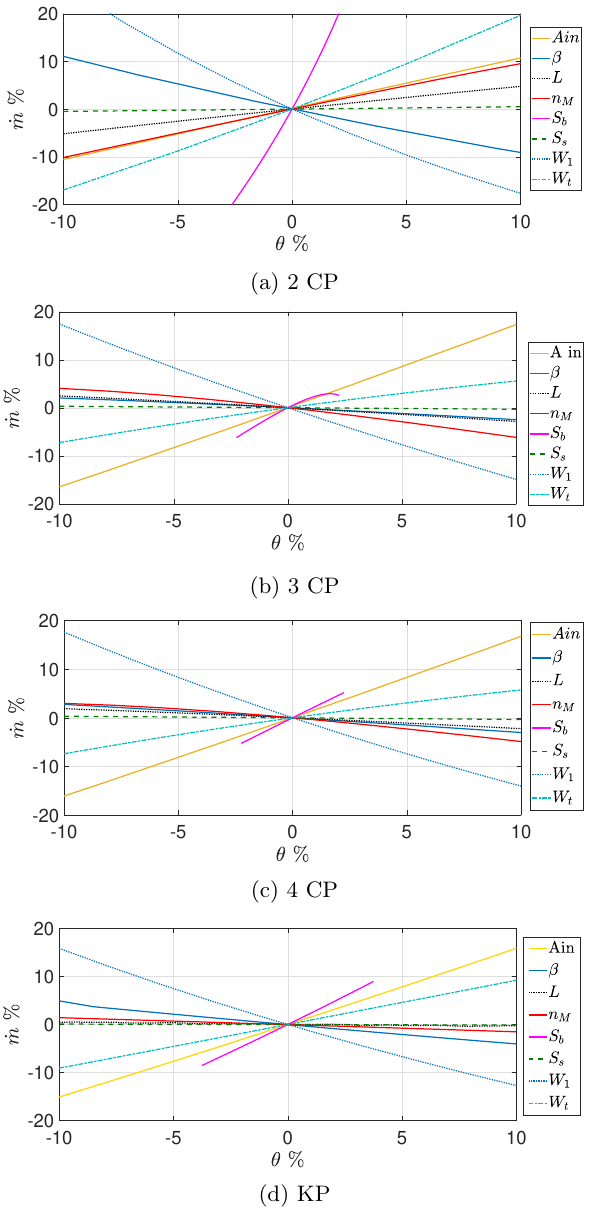
Figure 6: The spider plots showing the relationship of percentage mass flow rate to the percentage deviation of each parameter ( θ ) from their nominal